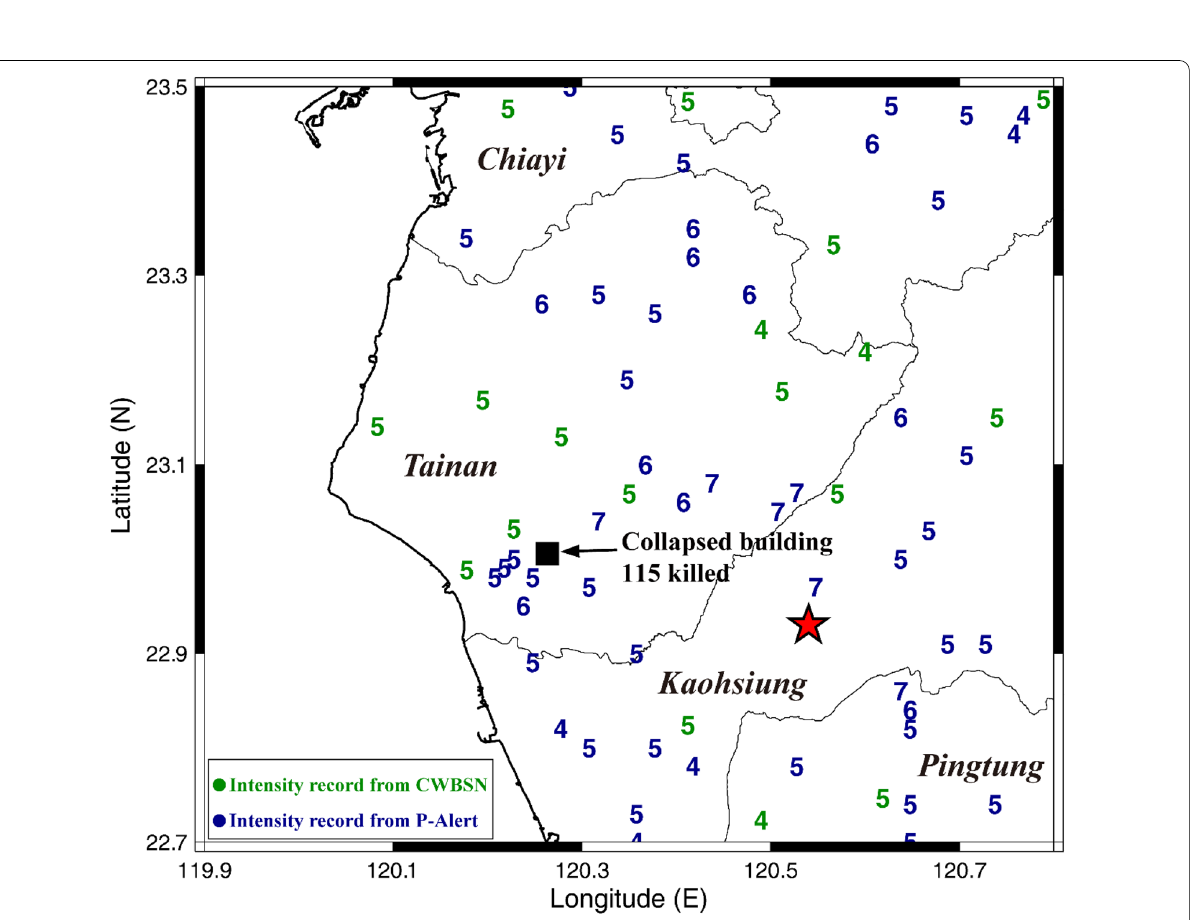
Fig. 8 The difference in intensity scale by CWB and P‑Alert